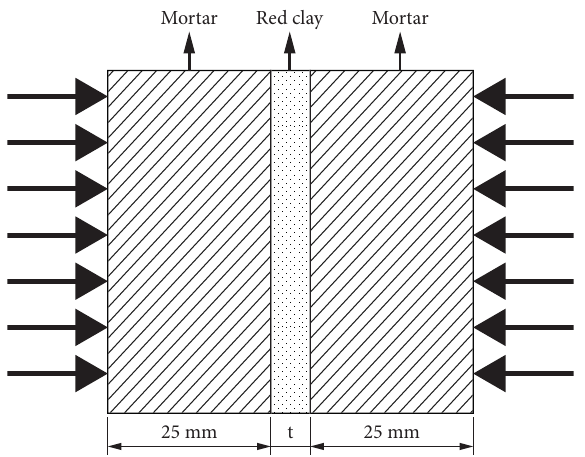
Figure 2: Schematic diagram of the composite specimen with diferent flling medium